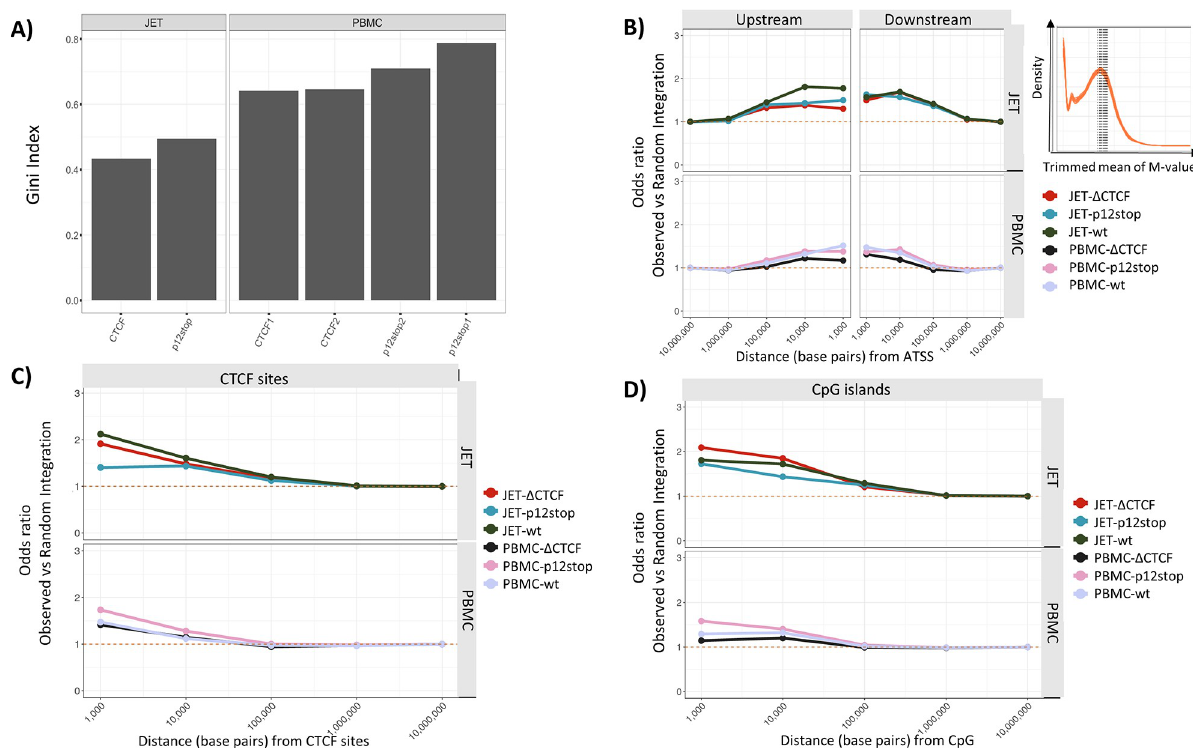
Fig 4. Effect of CTCF-BS Mutation on HTLV-1 Integration Sites. A) Clonality of HTLV-1 and HTLV-1 Δ CTCF integration sites in JET cells and PBMCs, as measured by the Gini index. Inconsistent results were obtained with HTLV-1 WT infected cells. B-D). Frequency distribution of observed WT HTLV-1, HTLV-1p12stop, and HTLV-1 Δ CTCF integration sites compared to random expectation within indicated window sizes (base pairs) in JET cells and PBMCs. B) Frequency of integration positions relative to upstream or downstream active transcription start sites (ATSS). The inset shows the transcriptional frequency of active genes in normal CD4+ T lymphocytes, with the shaded gene showing that for Fox P3. C) Frequency of HTLV integration sites relative to cellular CTCF sites. D) Frequency of HTLV integration sites relative to CpG islands.